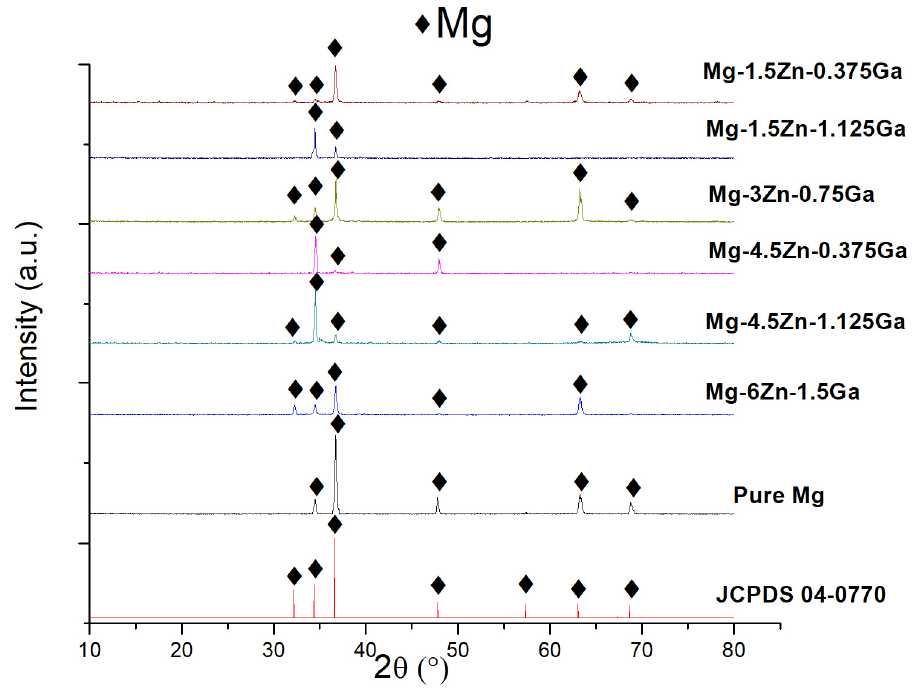
Figure 3. XRD pa tt erns of the as-cast Mg-Ga-Zn alloys before immersion in SBF.